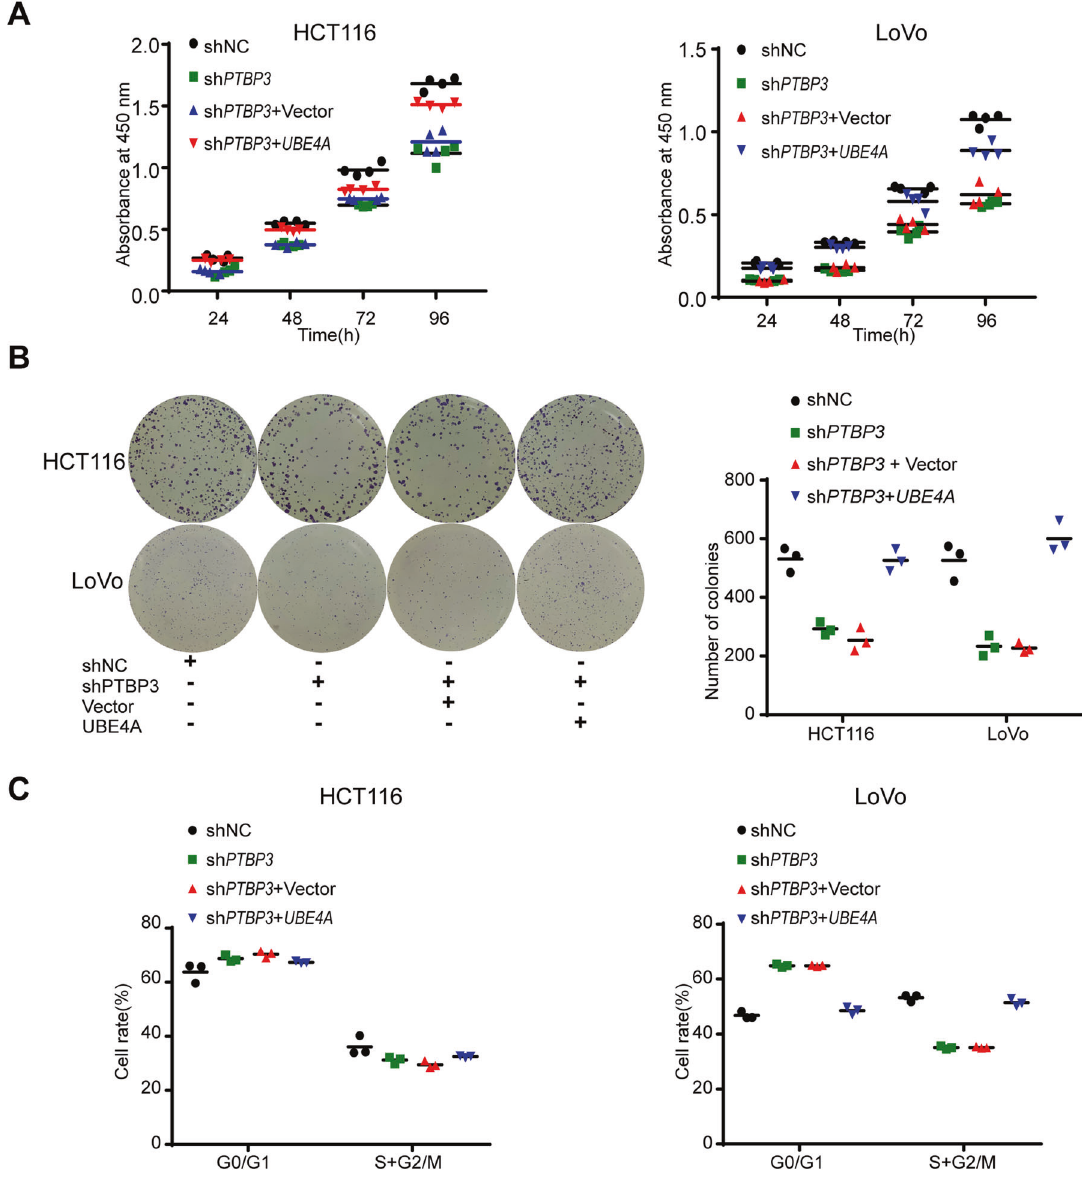
Fig. 6 Overexpression of UBE4A restores cell proliferation in PTBP3 knockdown CRC cells. A PTBP3 knockdown HCT116 and LoVo cells were transfected with the UBE4A plasmid, and the proliferation ability was quanti fi ed using the CCK-8 assay (two-way ANOVA, P < 0.001). B PTBP3 knockdown HCT116 and LoVo cells were transfected with the UBE4A plasmid, and the colony formation ability was quanti fi ed using the colony formation assay (two-tailed Student ’ s t -test, P < 0.01). C PTBP3 knockdown HCT116 and LoVo cells transfected with the UBE4A plasmid were analyzed by fl ow cytometry. The results are presented as means ± s.d. and are representative of at least three independent experiments (two- tailed Student ’ s t -test, P <